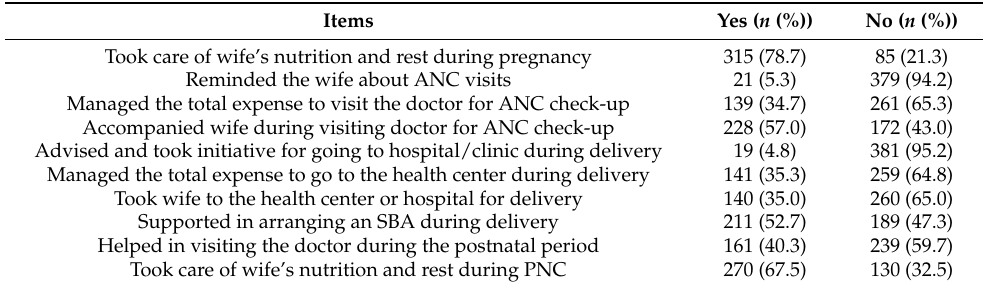
Table 4. Multivariate logistic regression predicting husbands’ involvement in wives’ ANC, child- birth and PNC.